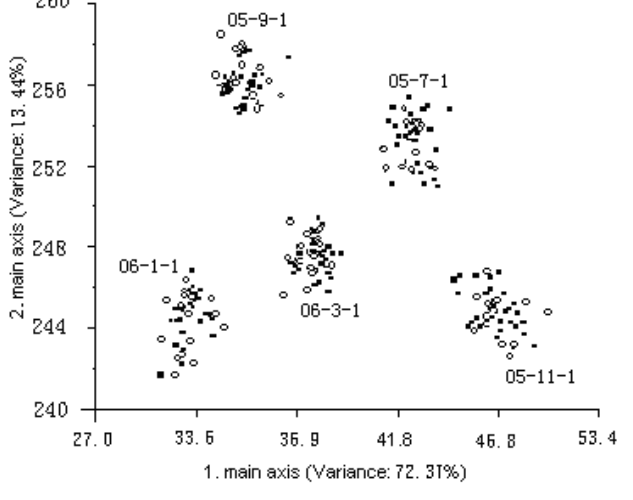
Figure 2. Discrimination and testing result of LDA based on the tea leaves.